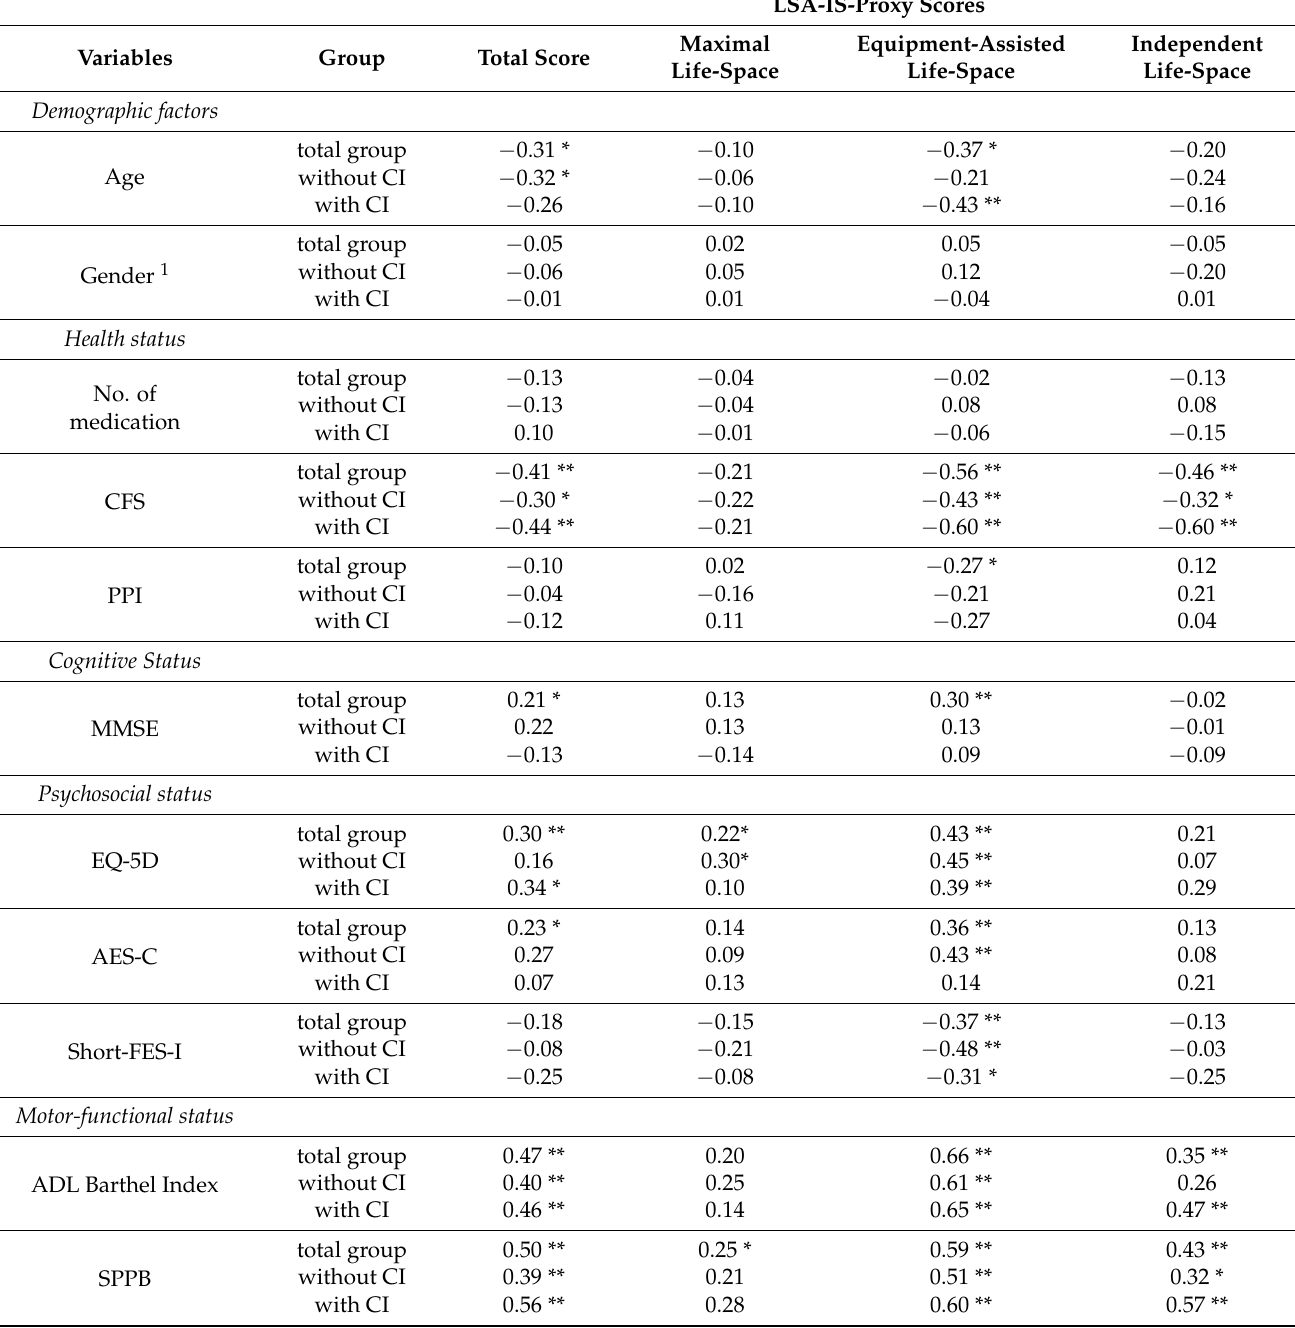
Table 3. Construct validity of the